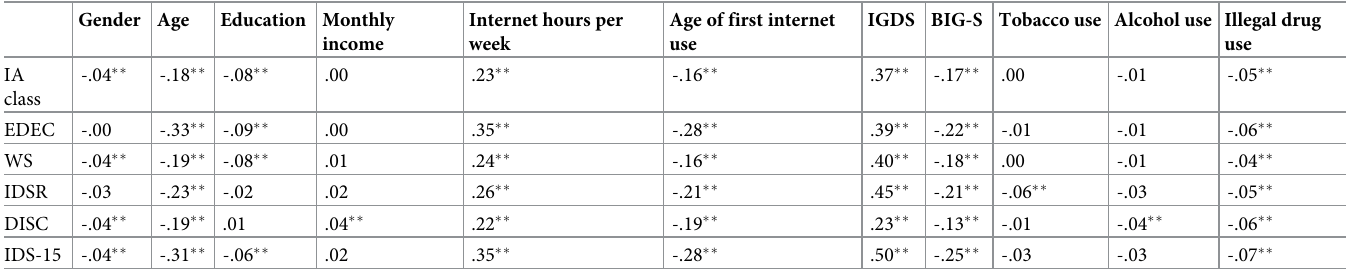
Table 5. Bootstrapped correlation matrix between IDS-15 (and its dimensions) and key demographic and criterion variables. Gender